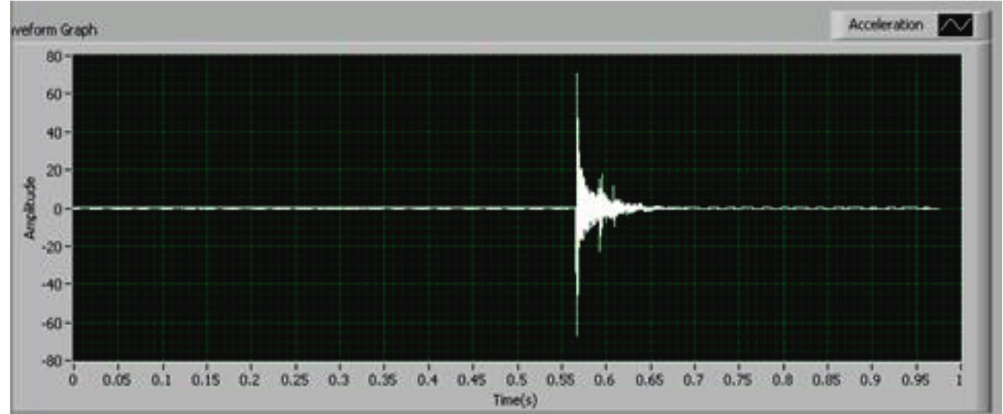
Figure 7: Time (sec) domain excitation response of Mg alloy under loading condition (4kg).